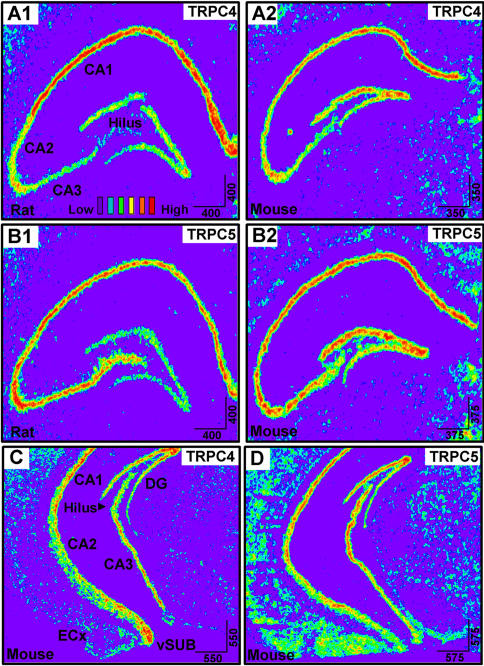
Expression of TRPC4 and TRPC5 in the hippocampal formation.(A1, A2) cRNA labelling of TRPC4 mRNA in rat and mouse CA1-3, hilus, and dentate gyrus (B1, B2) cRNA labelling of TRPC5 mRNA in rat and mouse CA1-3, hilus, and dentate gyrus (C) cRNA labelling of TRPC4 and 5 in the ventral mouse hippocampal formation including the entorhinal cortex and ventral subiculum.